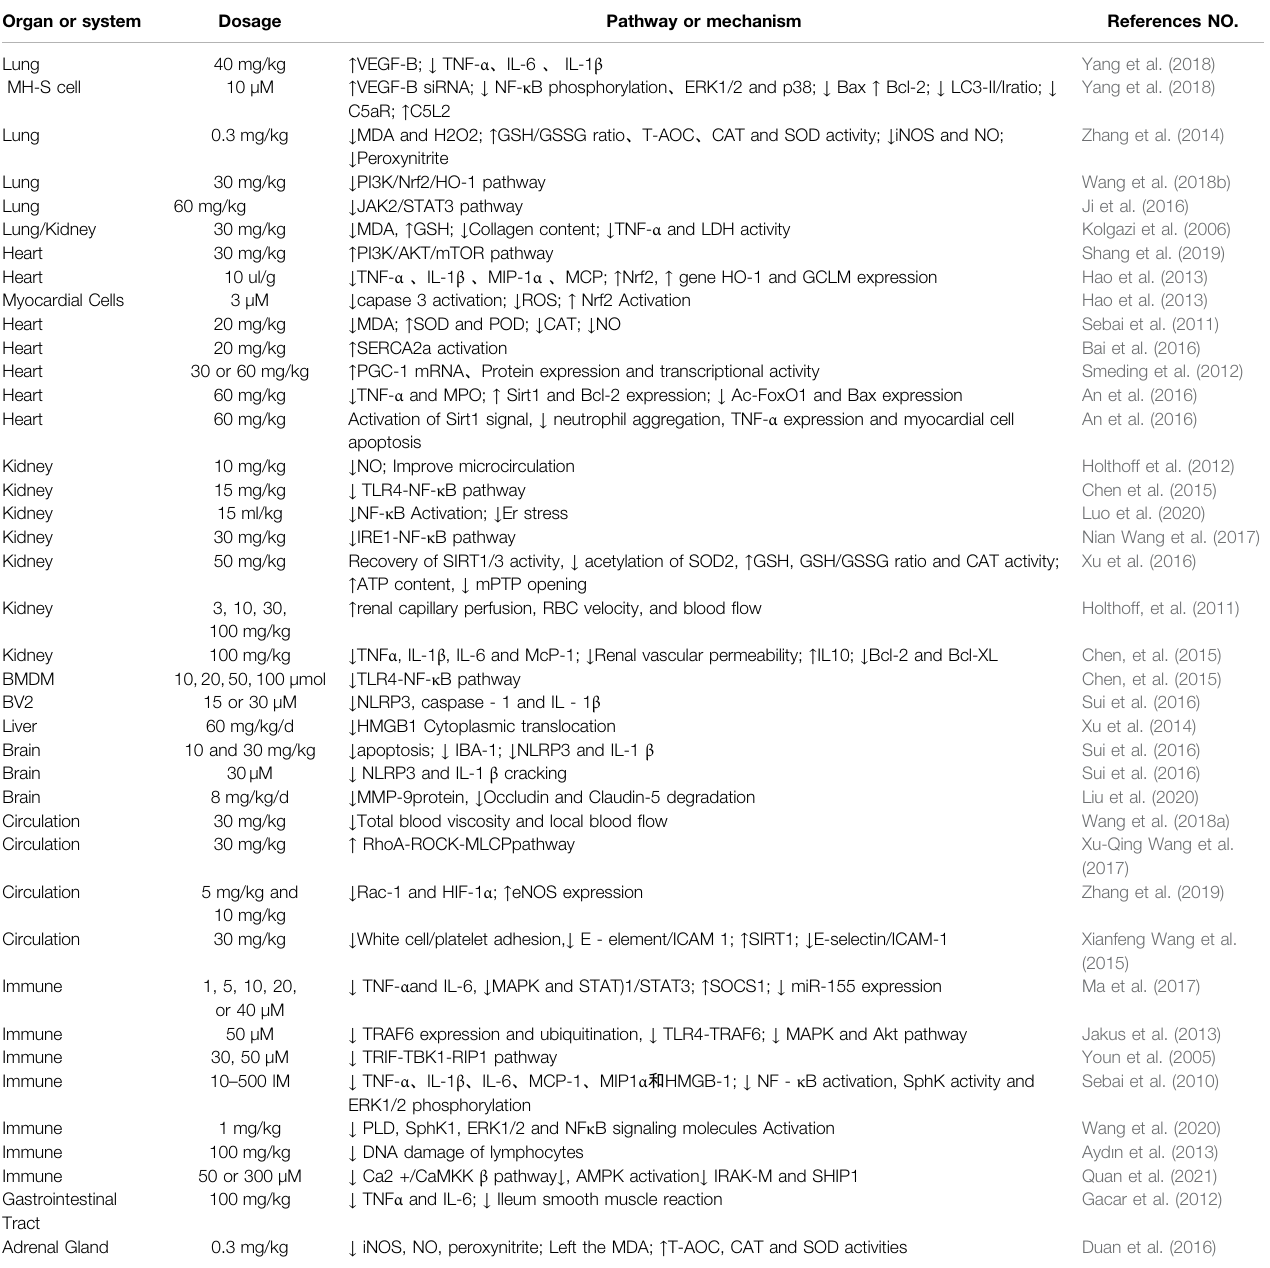
TABLE 1 | Application of resveratrol in different organs of sepsis models. Organ or